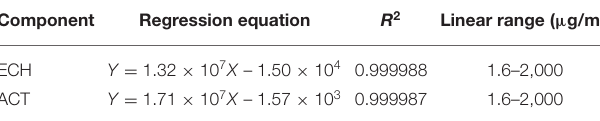
TABLE 2 | Calibration curves of ECH and ACT.